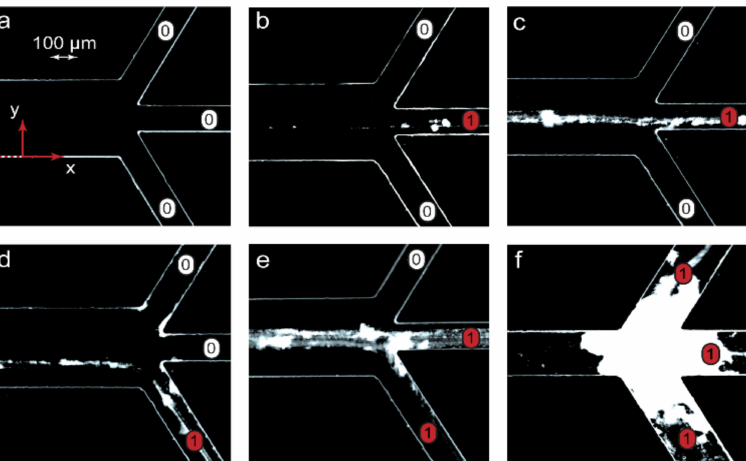
Figure 4. Visualization of chemical signals near microchip outputs (x = L) in the microfluidic experiments with the PDADMAC-SDS reaction pair: “1”—the product is present in an output (precipitate), “0”—no product in an output (no precipitate). The flow rates of the reagents and the solvent were identical to those of the numerical simulations shown in Figure 3: ( a ) A, B— 5 µ L/min, solvent—10 µ L/min; ( b ) A, B—5 µ L/min, solvent—3 µ L/min; ( c ) A, B—0.2 µ